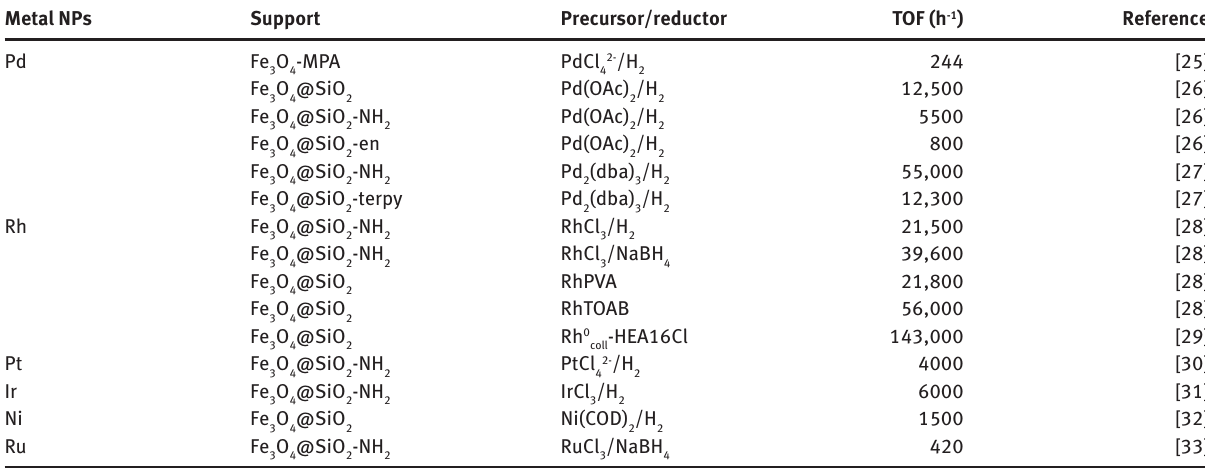
Table 1 Selected examples of magnetically recoverable metal NP catalysts and their application in the hydrogenation of cyclohexene. Metal NPs